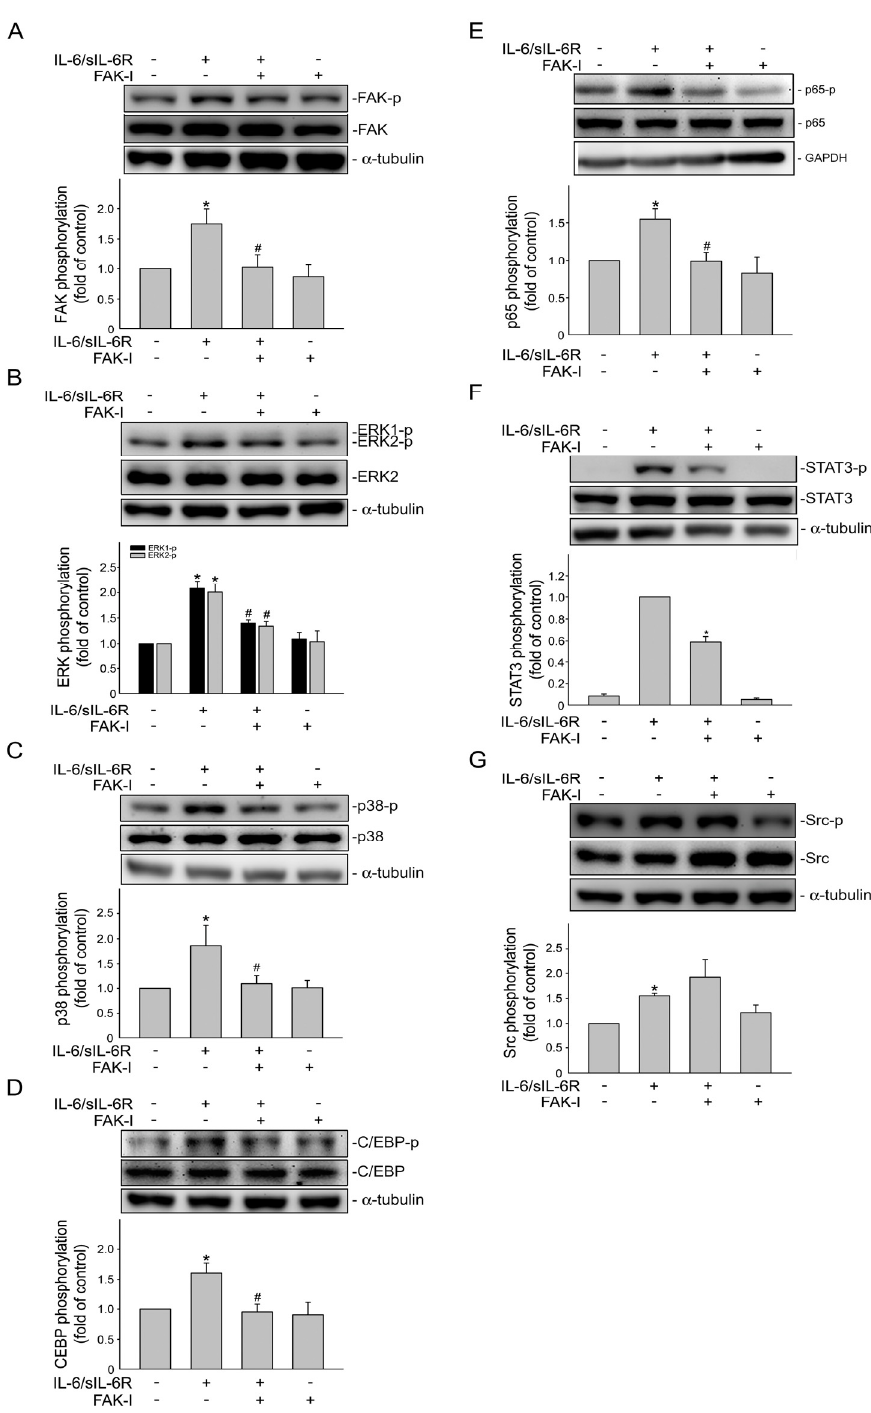
mean ± S.E.M. of four independent experiments. * p < 0.05, compared with the control group. # p < 0.05, compared with the group treated with IL-6/sIL-6R alone.